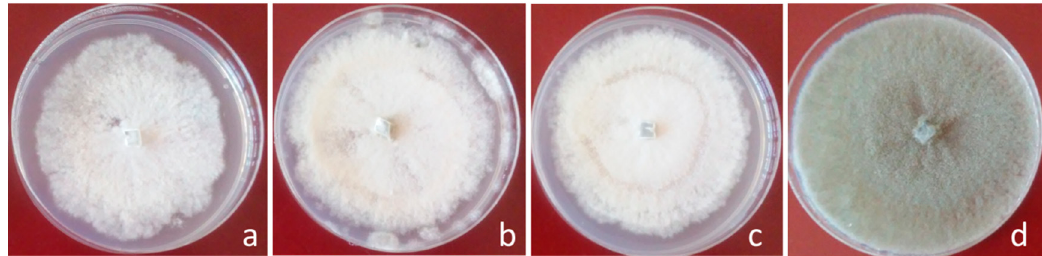
Figure 1. Macroscopic morphology of B. cinerea mycelia after 7 days of incubation in the presence of volatile compounds produced by the isolates Lc1 ( a ), Ac1 ( b ) and Ec1 ( c ). B. cinerea growth in the absence of volatile compounds ( d ).